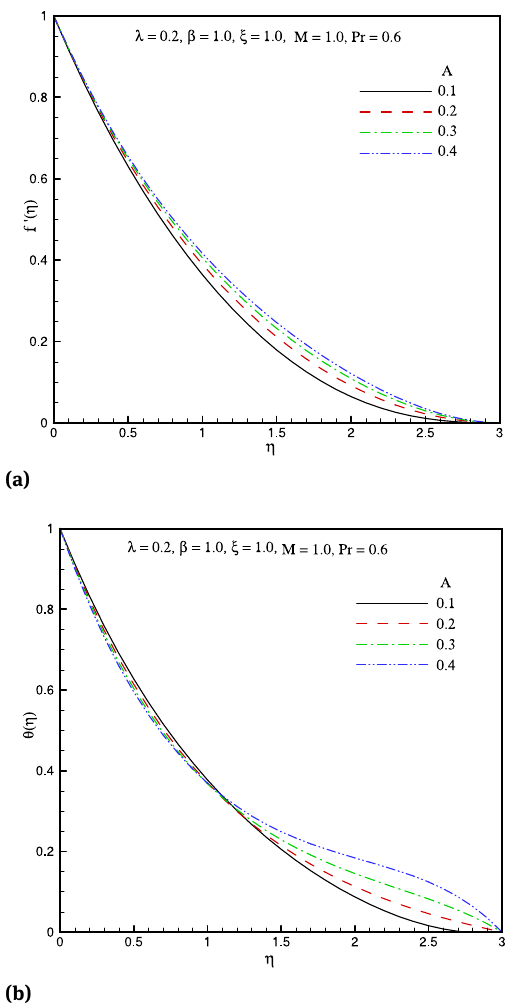
Figure 3: Simulated velocity and temperature profiles for different values of Jeffrey fluid parameter